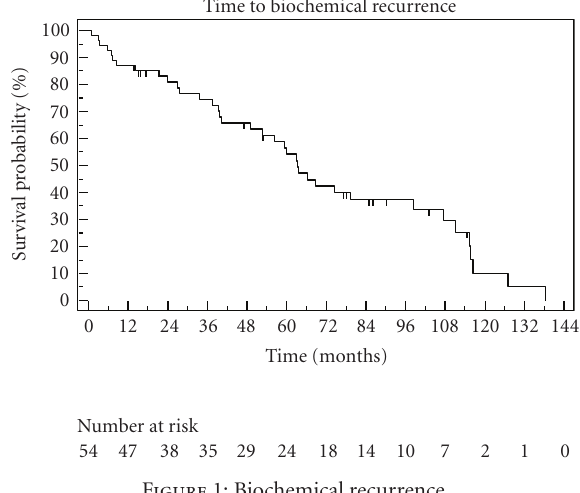
Table 2: Postoperative patient characteristics. Figure 1: Biochemical